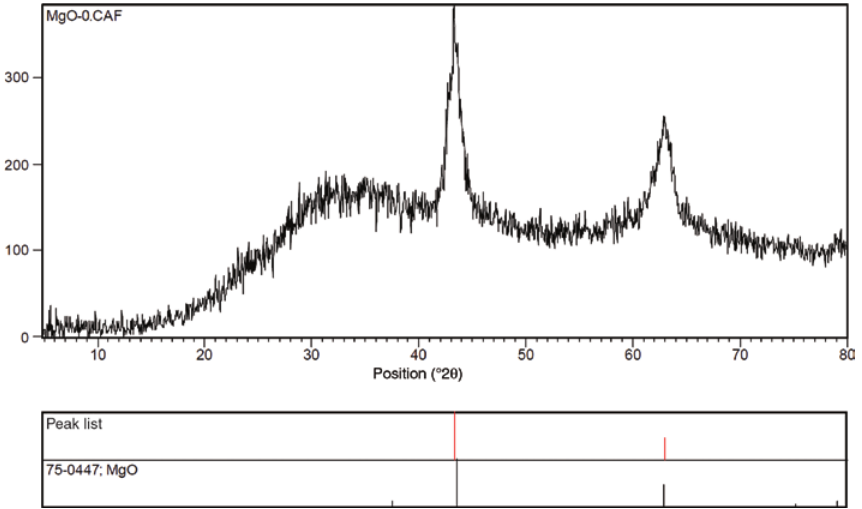
Figure 1: XRD patterns of MgO-2.